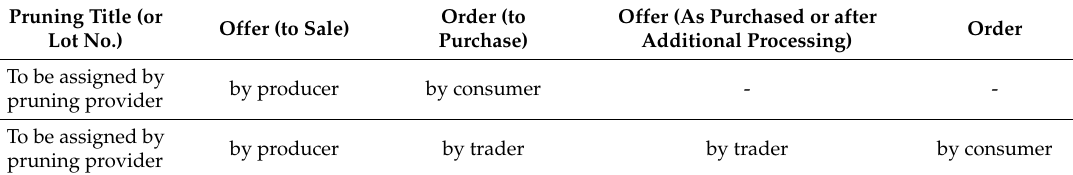
Table 5. Order tracking using smart logistics